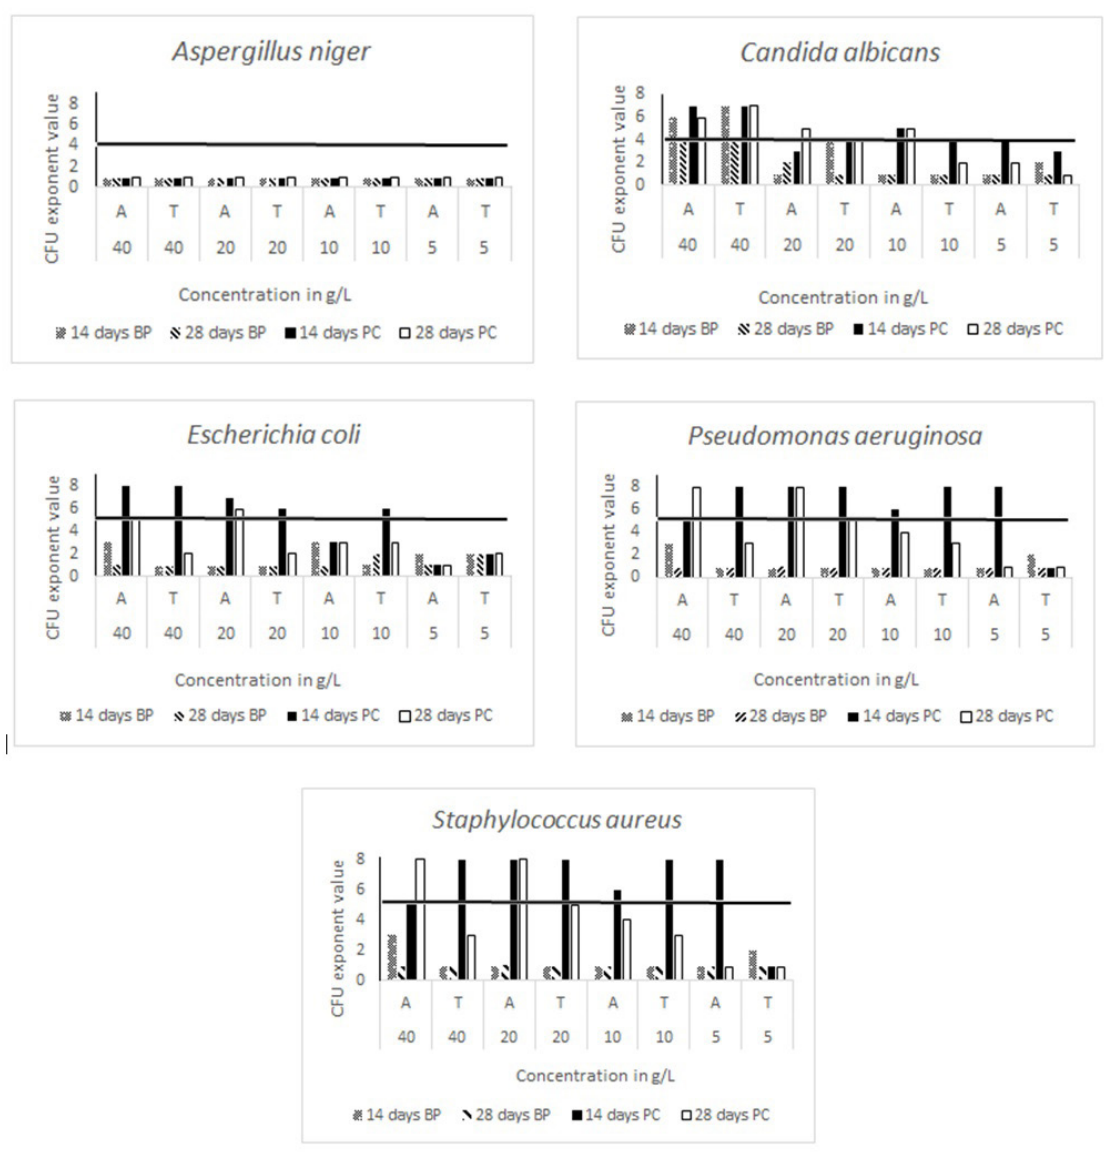
FIGURE 2 - Effect of preservatives BP and PC (0.5%), in the presence of nonionic surfactants PHCO (A) and PSO (T) at 5, 10, 20, and 40 g L -1 , on microbial growth of five test microorganisms after 28 days of